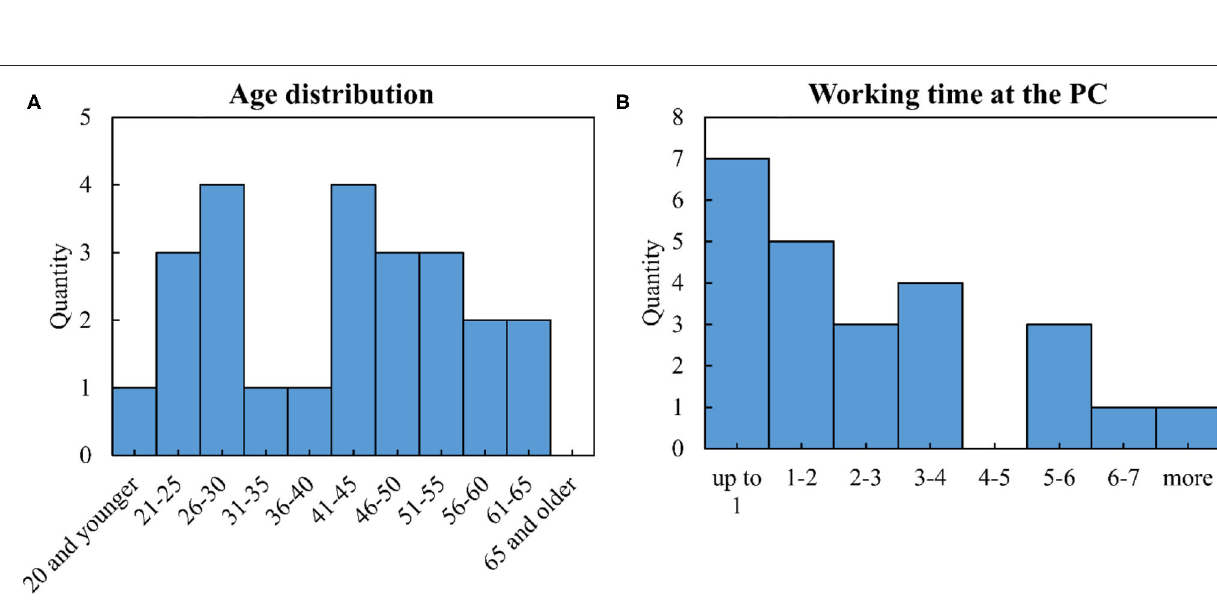
Frontiers in Robotics and AI |